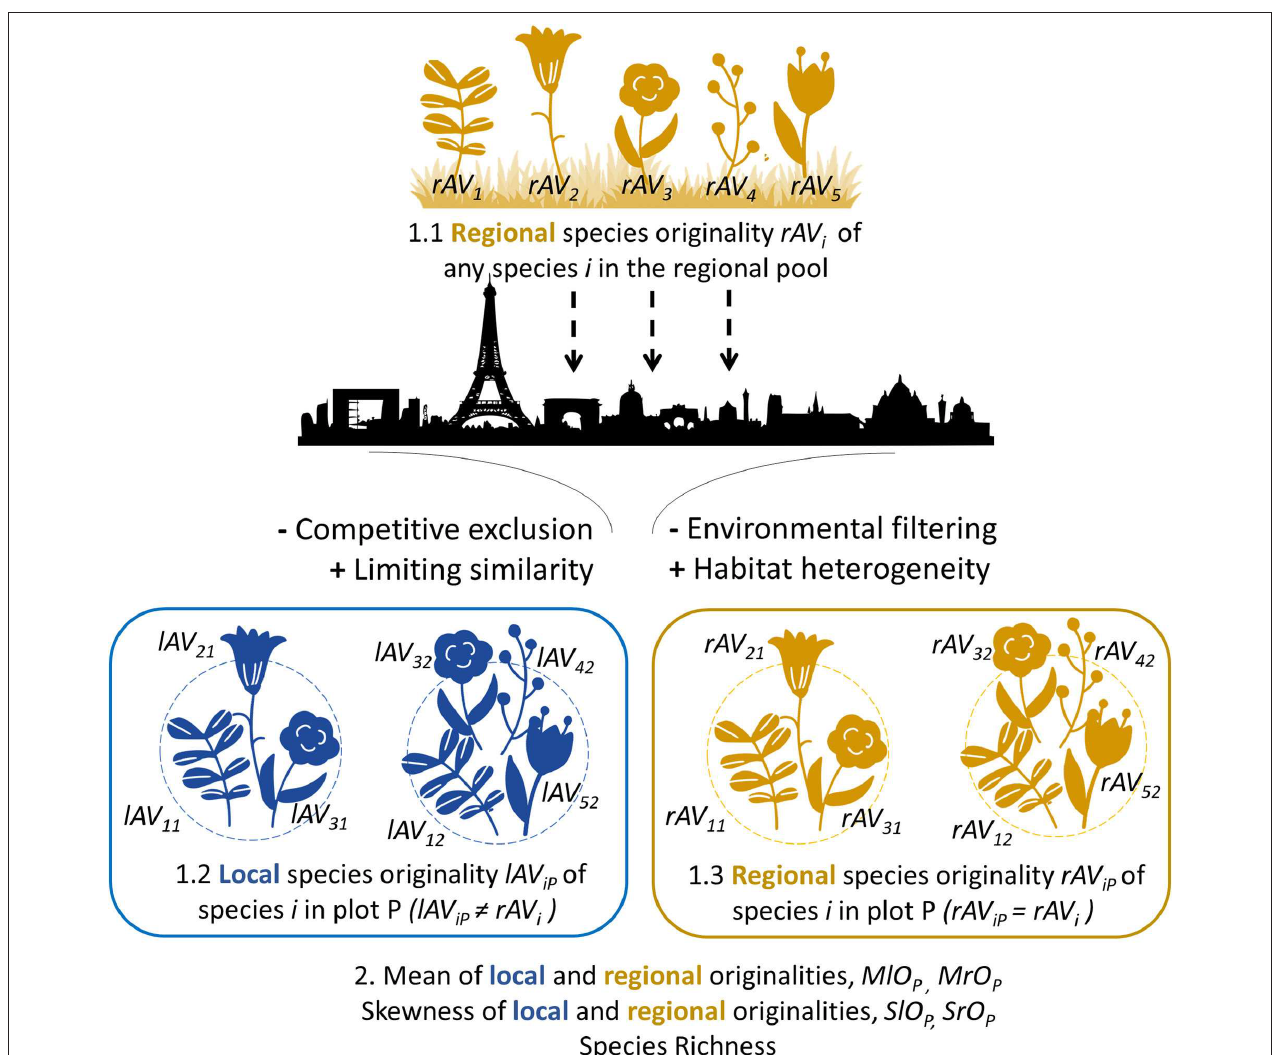
FIGURE 2 | Scheme of our methodological framework for the analysis of species originality at regional and local spatial scales. We illustrate this framework with a theoretical set of five plant species. First, the functional originality of species is calculated at the regional scale considering all species from the regional pool (1.1, rAV i ) and these values are reported for each species in a local plot P (1.3, rAV iP = rAV i ); originality values are also calculated at the local scale considering only species from a local plot P (1.2, lAV iP ). Finally, community metrics are measured for each plot P (2): the mean of regionally-measured originality values ( MrO P = mean of rAV iP values over i ) and their skewness ( SrO P = skewness of rAV iP values over i ), the mean of locally-measured originality values ( MlO P = mean of lAV iP values over i ) and their skewness ( SlO P = skewness of lAV iP values over i ), and the species richness (number of species). To illustrate potential effects of urbanization (represented by the city silhouette) on plant species communities, we indicated four key possible processes acting on the assembly of urban communities with potential positive or negative effect on community metrics (see Table 1 for a detailed description of possible scenarios of functional originality patterns in urban communities).